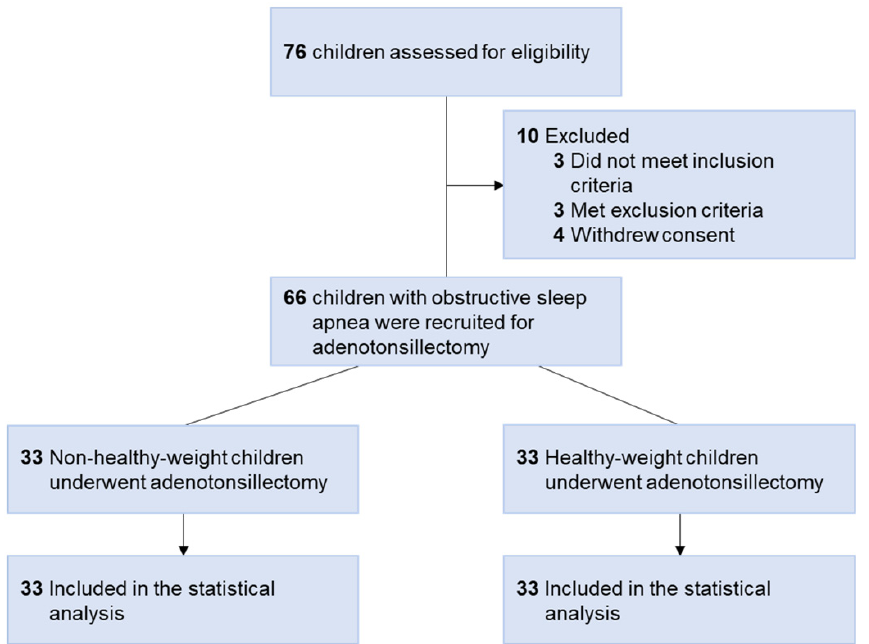
Figure 1. Flow diagram of the study. Seventy-six children with obstructive sleep apnea were assessed for eligibility. However, three did not meet the inclusion criteria, three met the exclusion criteria, and four withdrew consent. Therefore, a total of 66 children were recruited. The non-healthy-weight group included 33 children, and the healthy-weight group included 33 children. Both groups were matched by the proportion of chronic tonsillitis. All participants underwent adenotonsillectomy. Therefore, 66 participants were included in the primary analysis.